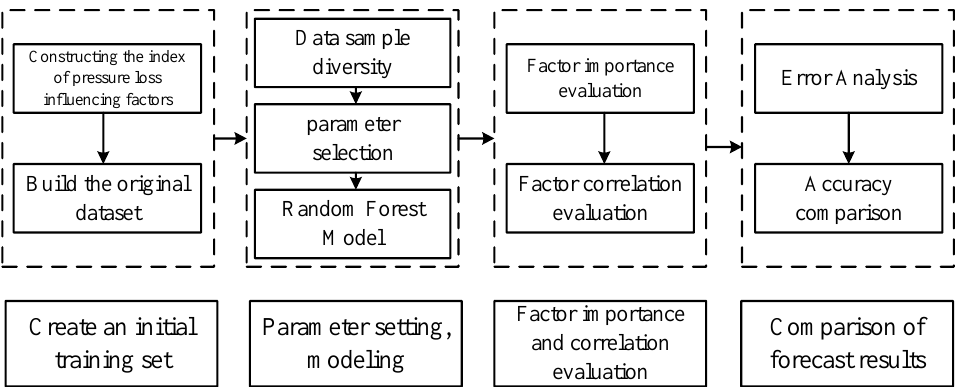
Figure 2. Random forest pressure drop prediction flowchart. The slurry pressure drop data were obtained through the loop pipe experiment, and some data are shown in Table 3. Table 3. Test sample